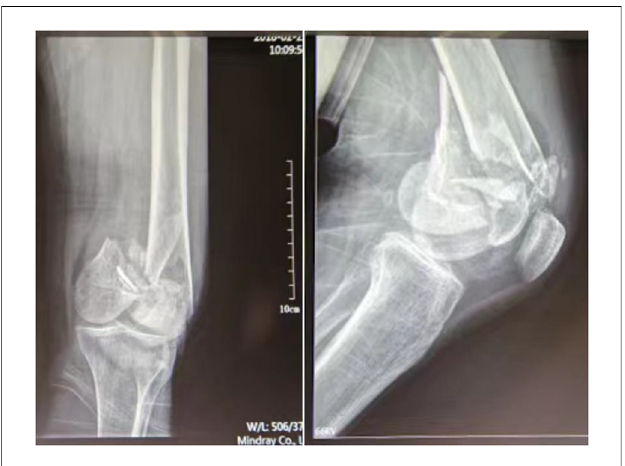
FIGURE 1 Preoperative x-ray of intercondylar supracondylar fracture of the left